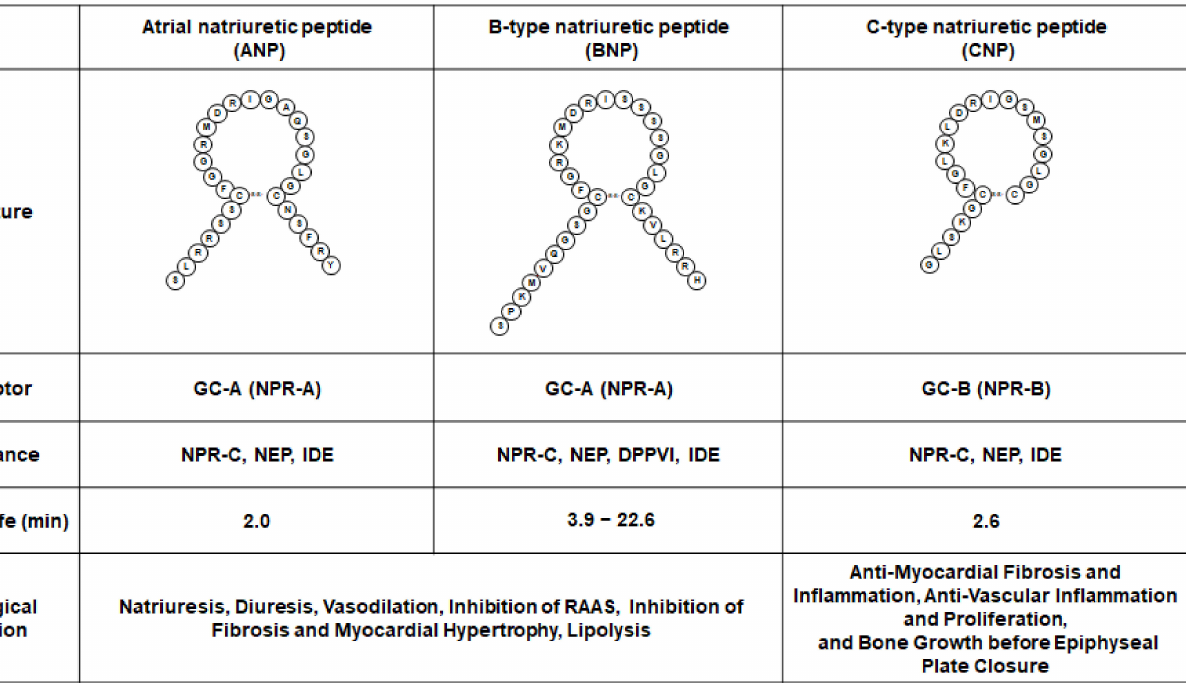
Figure 1. Native natriuretic peptides in human. DPPIV, dipeptidyl peptidase-4; GC-A, guanylyl cyclase-A; GC-B, guanylyl cyclase-B; IDE, insulin degrading enzyme; NEP, neprilysin; NPR-A, natriuretic peptide receptor A; NPR-B, natriuretic peptide receptor B; NPR-C, natriuretic peptide receptor C; RAAS, renin–angiotensin–aldosterone